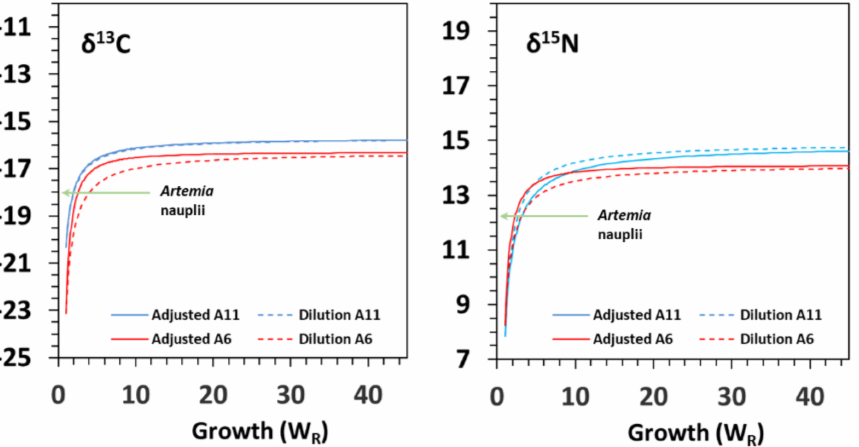
Figure 3. Model G–Relationships of changes in δ 13 C and δ 15 N (‰) as functions of the relative mass increase in seahorse Hippocampus reidi juveniles fed on diets A6 and A11. The curves refer to the feeding period on Artemia (6–60 DAR in diet A6 and 11–60 DAR in diet A11). Diet: Artemia nauplii ( − 18.03‰ δ 13 C; 12.27‰ δ 15 N). Dashed lines represent the dilution models.